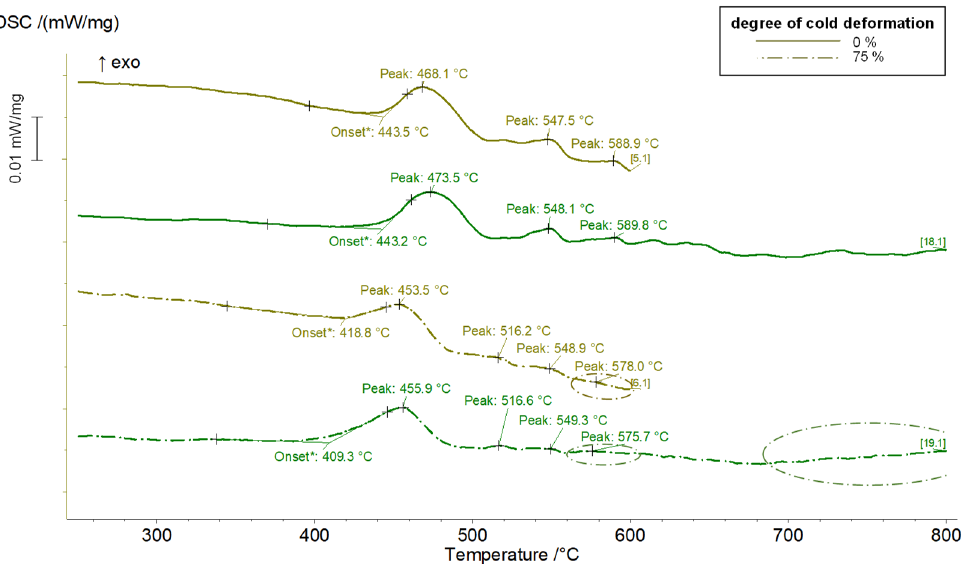
Figure 4. DSC measurement of CuCr0.7 with 0% (solid lines) and 75% (dot-dashed lines) cold deformation up to condition 1 (ochre color) and 2 (green color) with peak and onset temperatures for the primary precipitation effect, as well as the area of recrystallization.